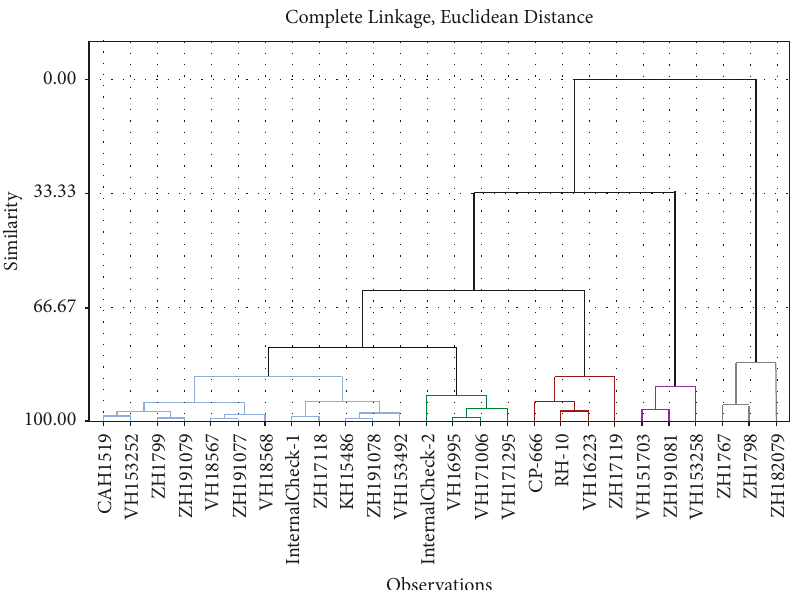
Figure 2: Dendrogram showing cluster analysis of 26 genotypes of